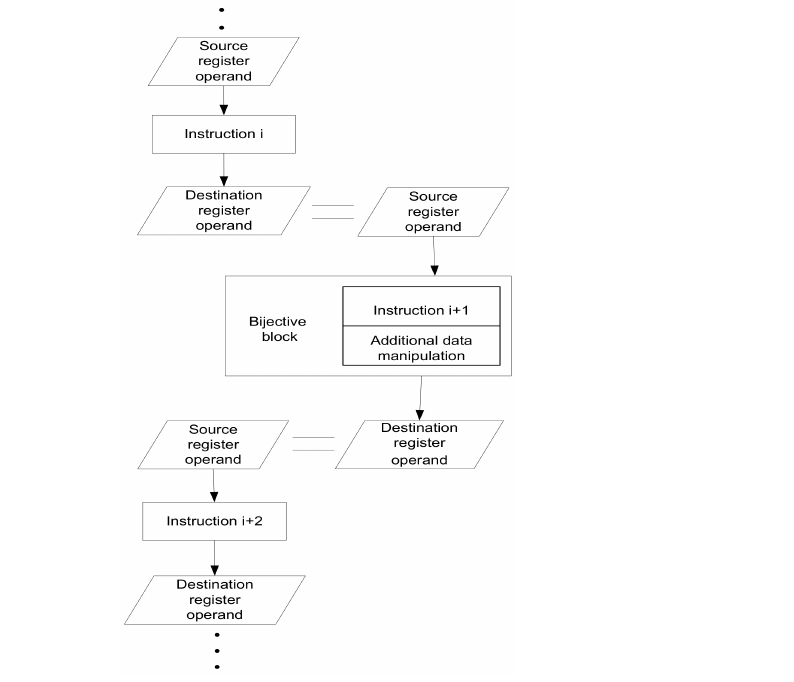
Figure 2. Our solution-sensitive path approach. A part of the test